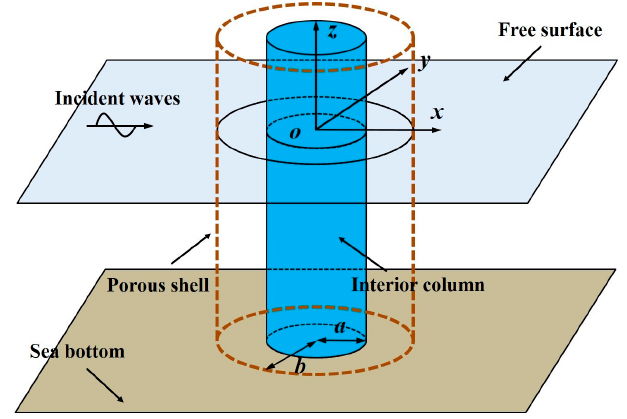
Figure 1. Definition sketch for a concentric porous cylinder system.